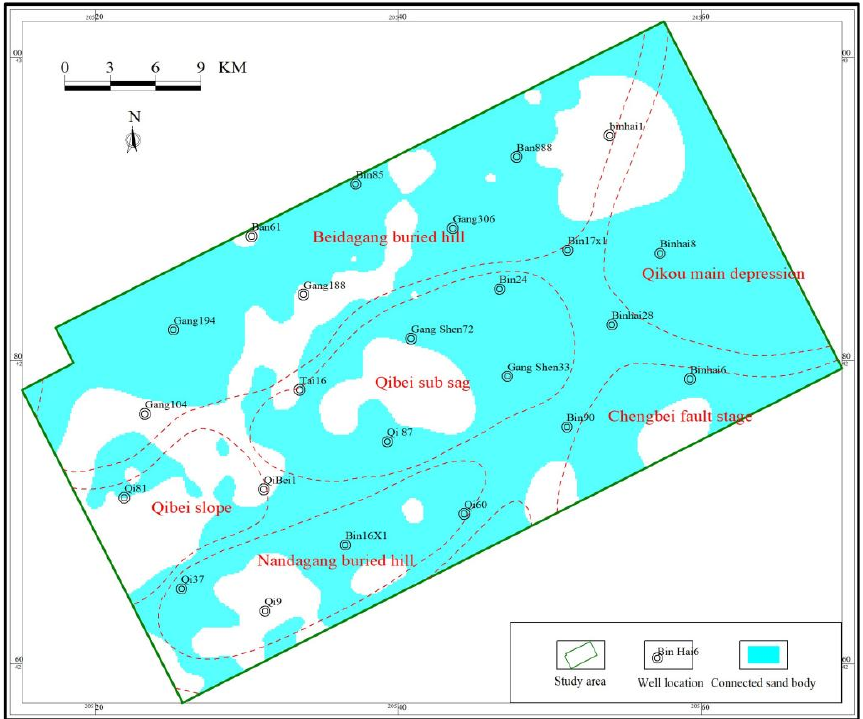
Figure 6. Connected sand bodies in Sha-3 source rocks in the south of the northern Dagang area.